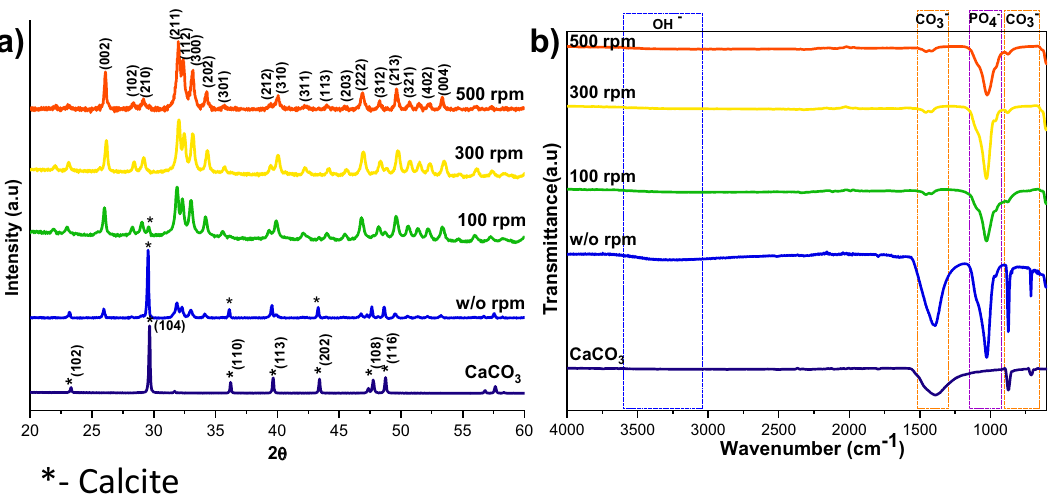
Figure 1. XRD ( a ), and FTIR ( b ) spectra of HAp prepared at a different stirring rate (CaCO3 JCPDS no: 05-0586 and HAp JCPDS no: